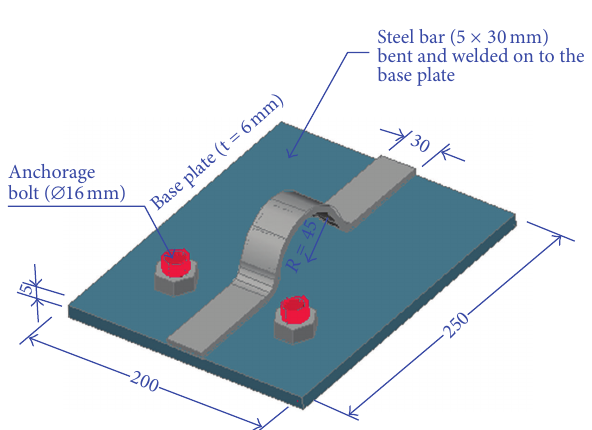
Figure 2: Details of panels.